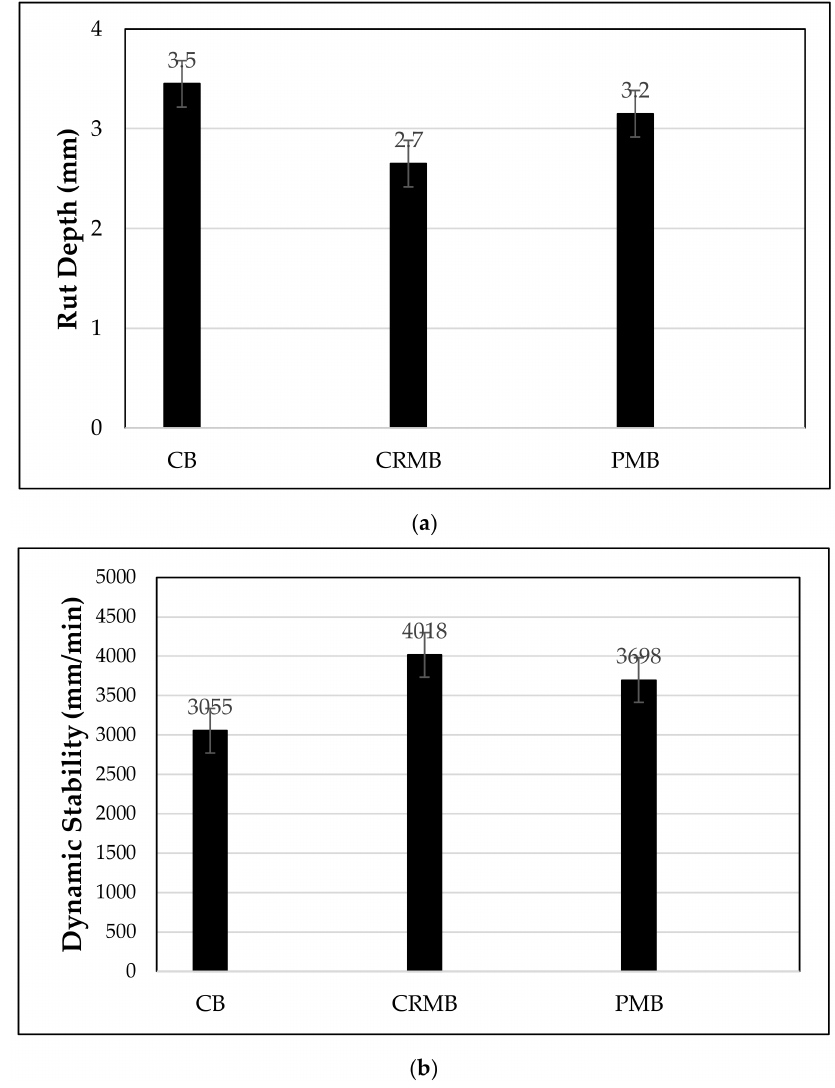
Figure 6. Rut test results: ( a ) rut depth and ( b ) dynamic